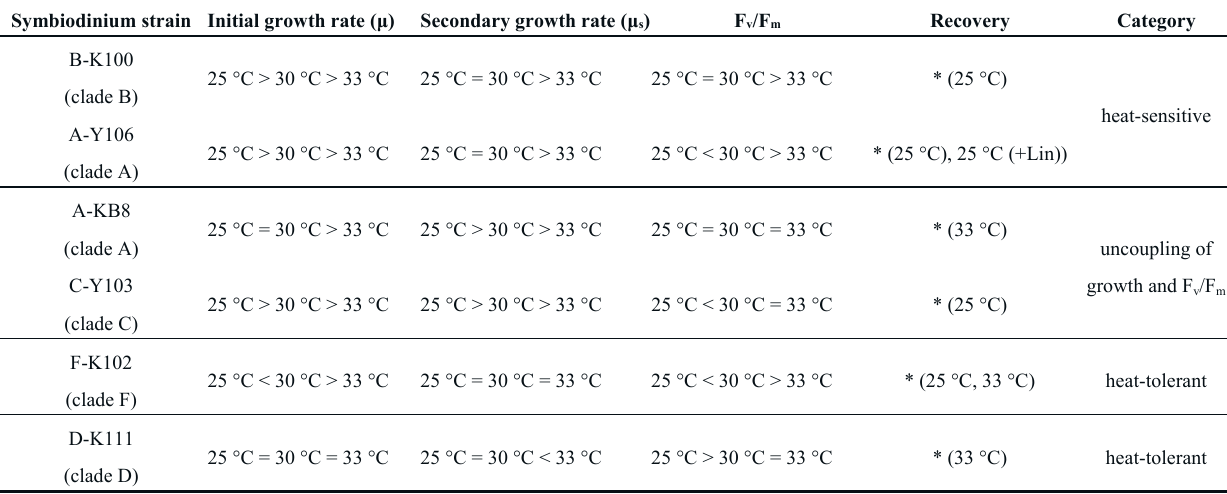
Table 1. Effects of temperature on the initial growth rate, secondary growth rate, and F v /F m of the Symbiodinium strains. Conditions under which significant recovery from photodamage was observed are also